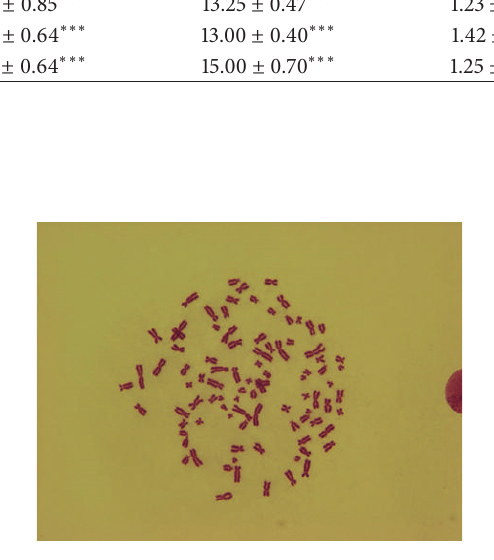
Figure 4: Polyploidy (125 𝜇 g/mL dirithromycin, 24 h treatment, D